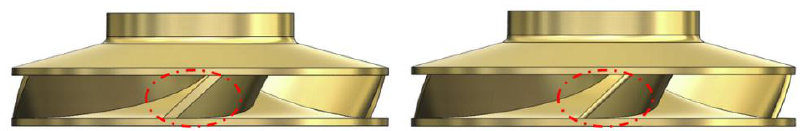
Figure 1. Design of impeller rounding. ( a ) Section of the impeller front view; ( b ) section of the impeller side view.